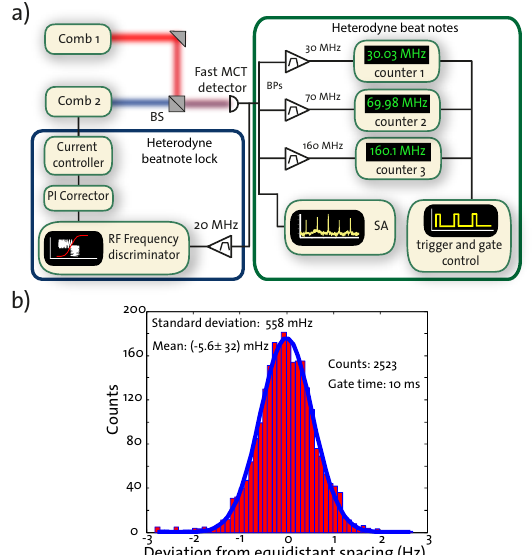
Figure 16: Measurement of the deviation from equidistant mode spacing. a Schematic representation of the setup used for mea- suring the deviation from equidistant mode spacing ϵ based on a multi-heterodyne measurement. SA: spectrum analyzer, BPs: band-pass filters, BS: beam splitter, PI: proportional integral, MCT: Mercury cadmium telluride. b Distribution of the deviation from equidistance mode spacing ϵ . Total measurement time = 25.23s. Gate time = 10ms. The distribution shows a Gaussian distribution with an average value of (−5.6 ± 32) mHz and a standard deviation of 558mHz. Results published in [76].